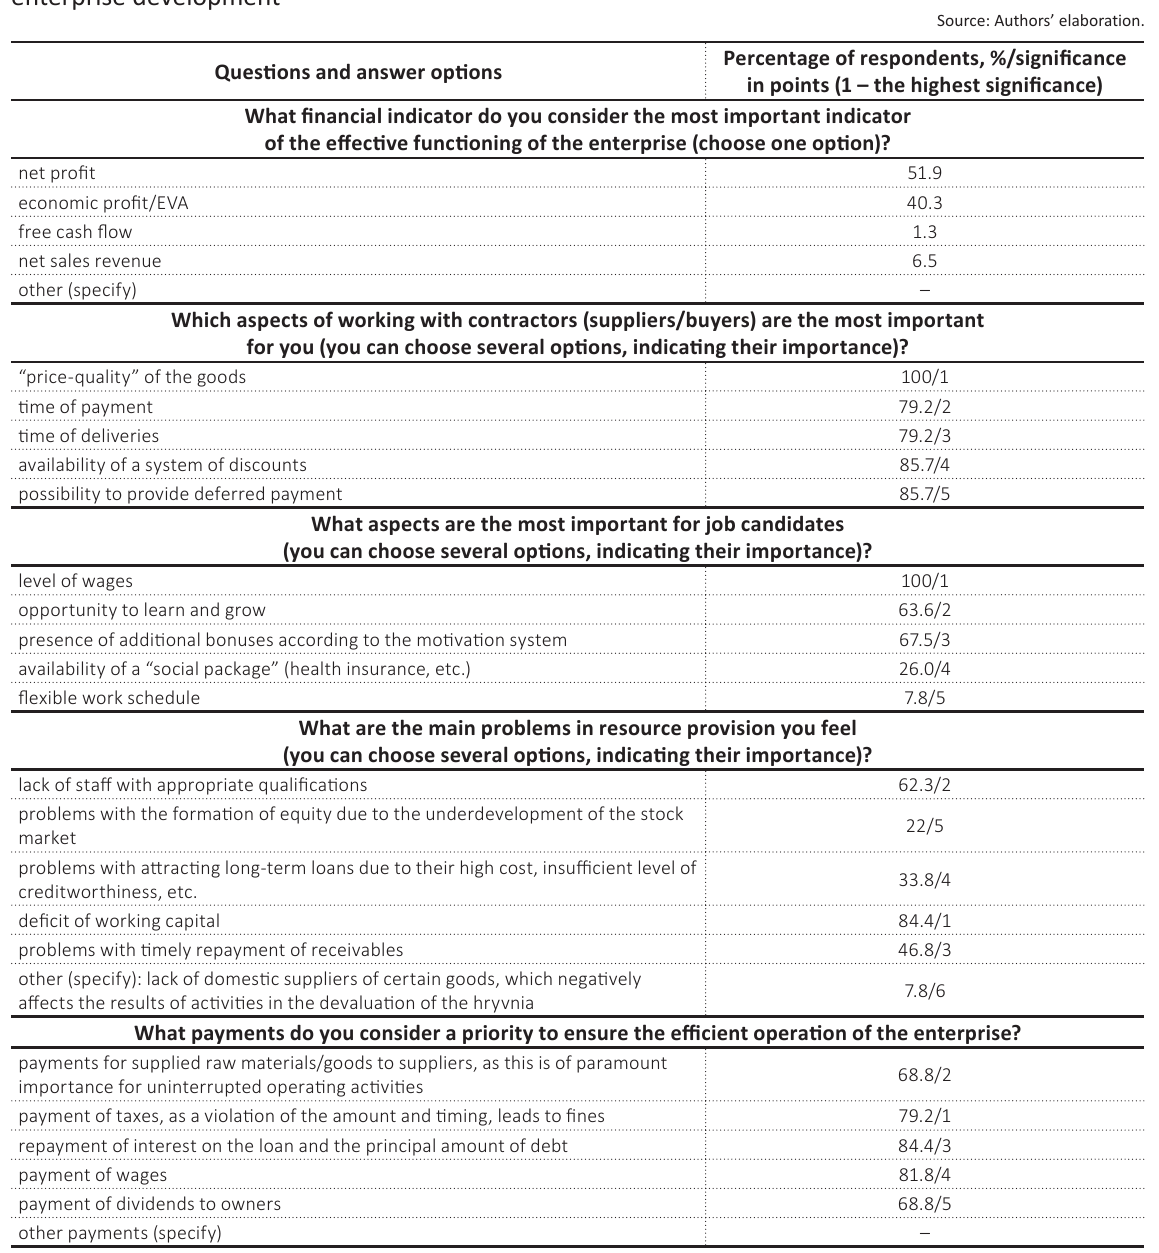
Table 5. Expectations of stakeholders from resource exchange and the problem of ensuring effective enterprise